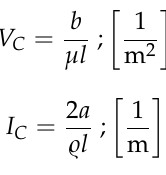
Figure 8. Example of simulation results for the reactor with 13 layers of spheres with a diameter of 3 mm, showing distributions of:( a ) velocity, ( b ) pressure, ( c ) and temperature.